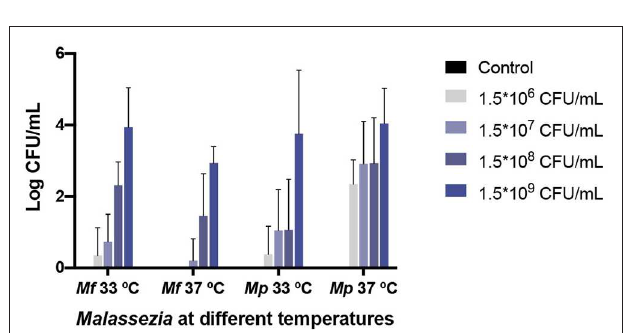
FIGURE 6 | M. furfur and M. pachydermatis isolated from challenged G. mellonella larvae. No significant difference was found in yeast isolation of the two Malassezia species ( p < 0.4068, 2-way ANOVA test). However, the recovery of yeasts from larvae challenged with M. furfur differed depending on temperature. At 33 ◦ C the fungal burden decreased but, in less proportion, than at 37 ◦ C. On the contrary, M. pachydermatis isolated from G. mellonella showed a better recovery at 33 ◦ C, similar yeast recovery was obtained for the highest inoculum concentration used. In all cases, the fungal burden demonstrated a decrease from the original inoculum concentration. Mf, M. furfur; Mp, M. pachydermatis .